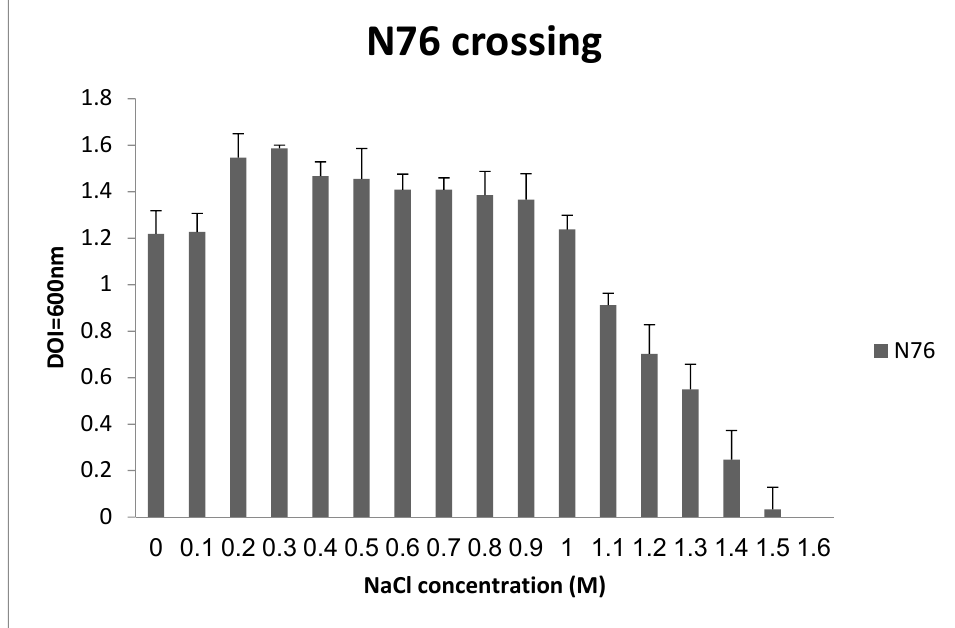
Figure 1. Impact of NaCl concentration (0–1.6 M) on the growth of isolate N76.